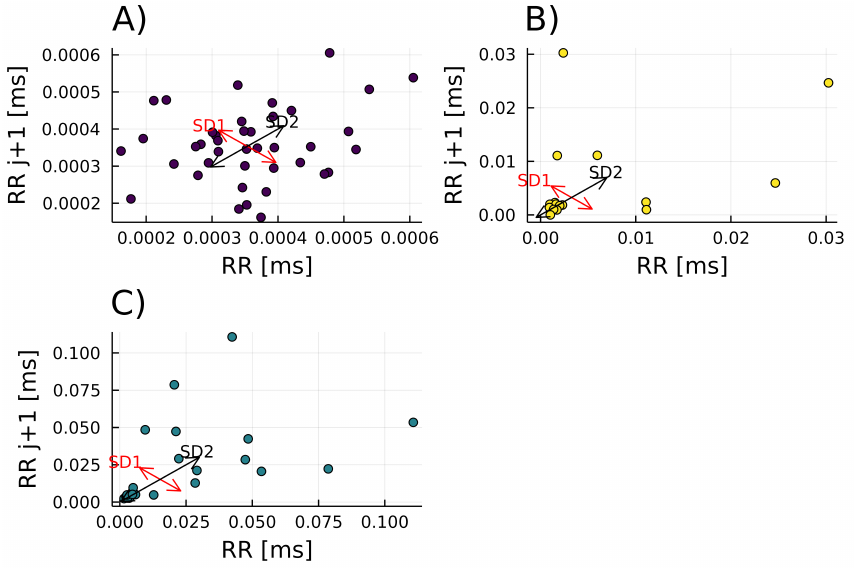
Figure 7. Poincaré of the 6-PP signal for the individual organisms ( A ) Arabidopsis thaliana (purple dots) (SD1 = 8.6795 × 10 − 5 , SD2 = 0.0001, SD1/SD2 = 0.7789), ( B ) Trichoderma atroviride (yellow dots) (SD1 = 0.004, SD2 = 0.007, SD1/SD2 = 0.58816), and ( C ) A. thaliana - T. atroviride interaction (green dots) (SD1 = 0.01545, SD2 = 0.0295, SD1/SD2 =